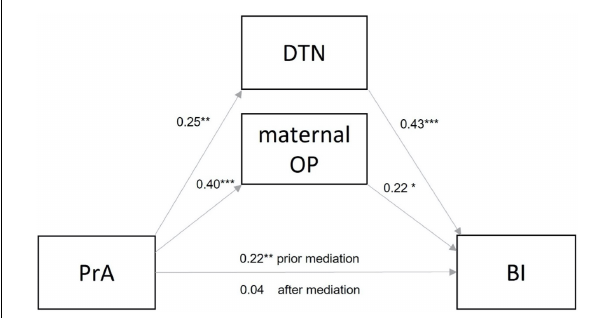
FIGURE 1 | Standardized estimates for the mediation model between pregnancy-related anxiety (PrA) and infant behavioral inhibition (BI), with the two parallel mediators infant distress to novelty (DTN) and maternal overprotection (OP). *** p < 0.001; ** p < 0.01; * p <